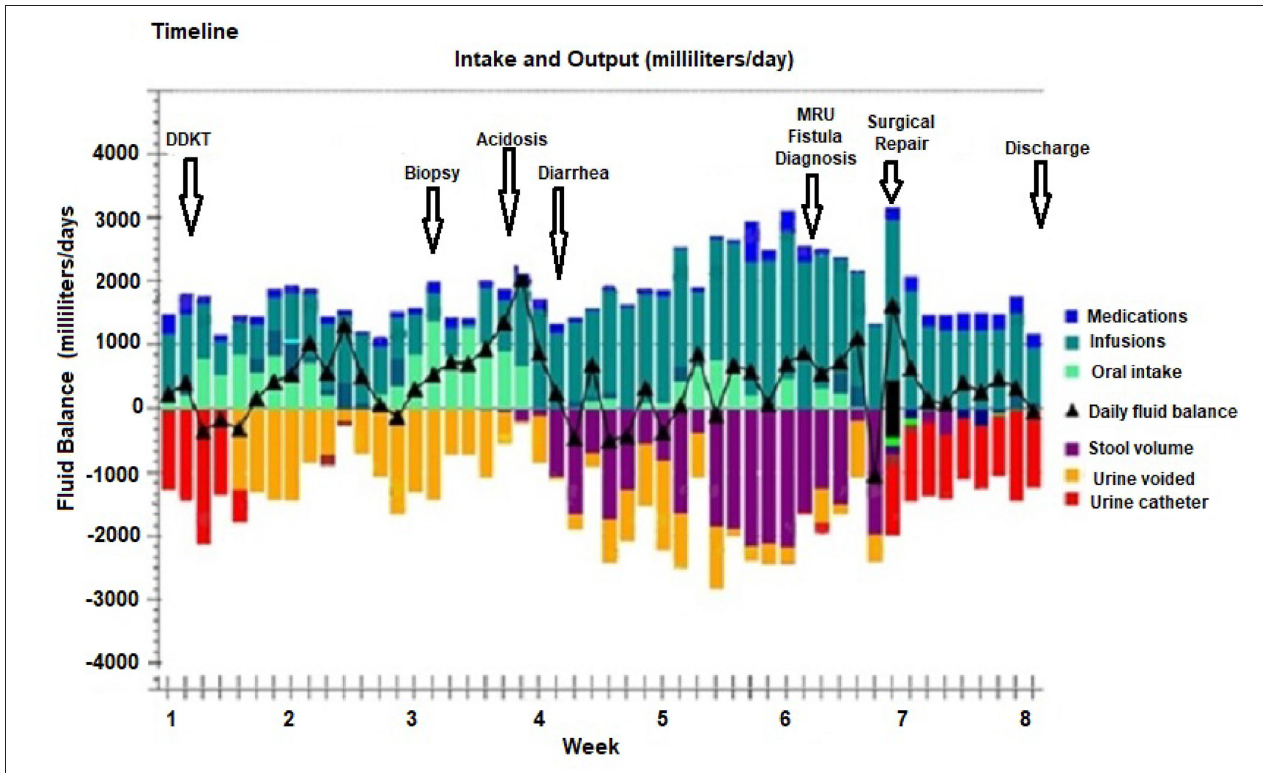
FIGURE 1 | Timeline from deceased pediatric donor en-bloc kidney transplant (DDKT), renal allograft biopsy with subsequent development of uroenteric fistula which manifested as normal anion gap acidosis and watery diarrhea which was diagnosed by magnetic resonance imaging urogram (MRU), followed by surgical repair and discharge after 8 weeks of hospitalization. The daily fluid balance with urine and stool volumes are color